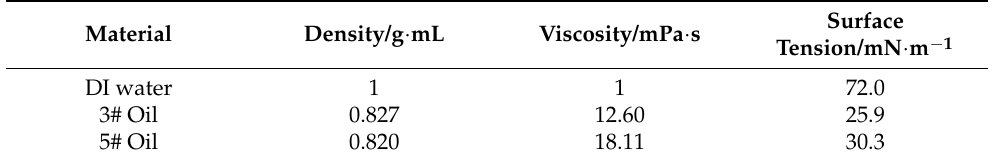
Table 1. Physical properties of